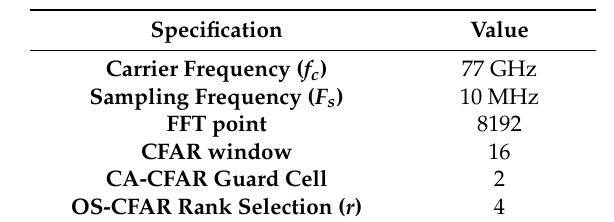
Figure 7. FMCW radar simulation block diagram. Table 1. Simulation parameters.